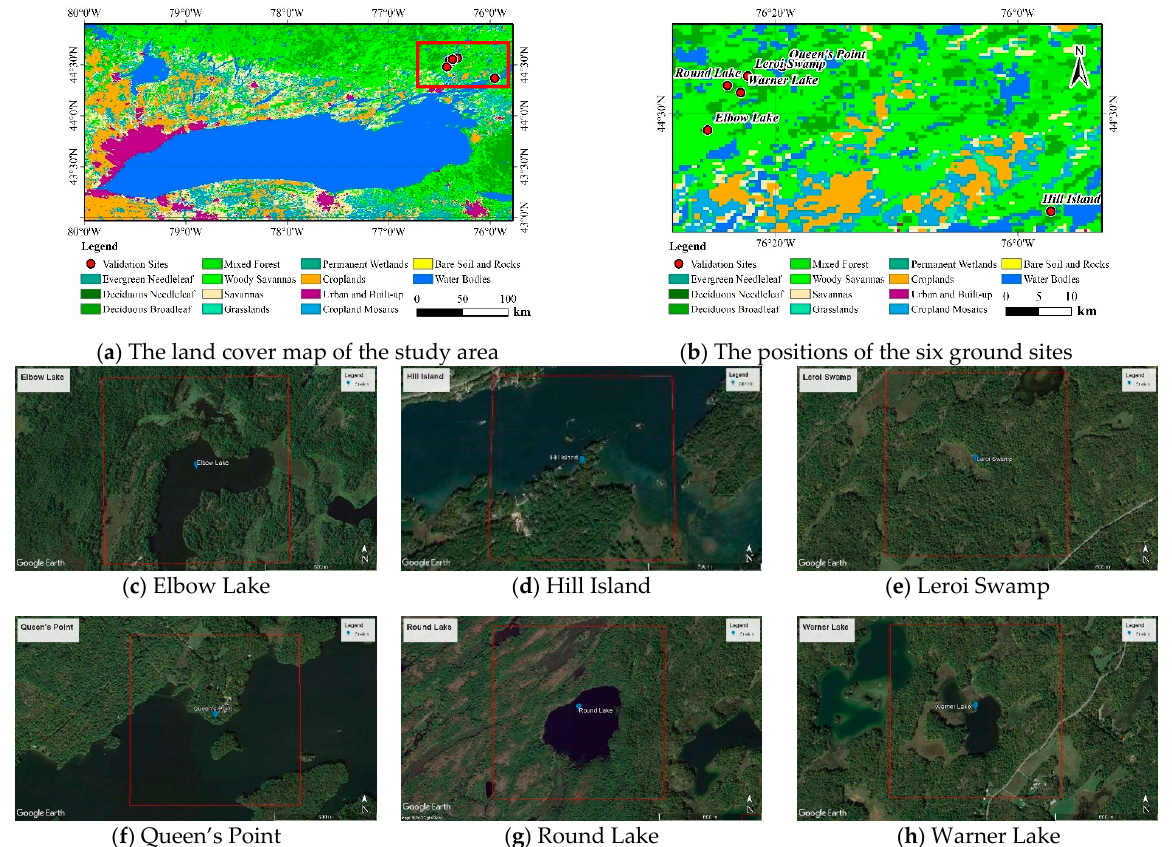
Figure 1. The land cover map of the study area ( a ) and the positions of the six ground sites ( b ) indicated by the red rectangles, obtained in 2017. The land cover map was obtained from MODIS land cover product MCD12Q1, in which the International Geosphere-Biosphere Program (IGBP) global vegetation classification was chosen: 1. Evergreen Needleleaf 3. Deciduous Needleleaf 4. Deciduous Broadleaf 5. Mixed Forest 8. Woody Savannas 9. Savannas 10. Grasslands 11. Permanent Wetlands 12. Croplands 13. Urban and Built-up 14. Cropland Mosaics 16. Bare Soil and Rocks 17. Water Bodies. The satellite images of the six ground sites are downloaded from Google Earth. ( c – h ) indicates the positions and land cover details of the six ground sites: ( c ) Elbow Lake, ( d ) Hill Island, ( e ) Leroi Swamp, ( f ) Queen’s Point, ( g ) Round Lake, ( h ) Warner Lake. Table 1. Characteristics of the six QUBS sites for flooding seasons between 2015 and